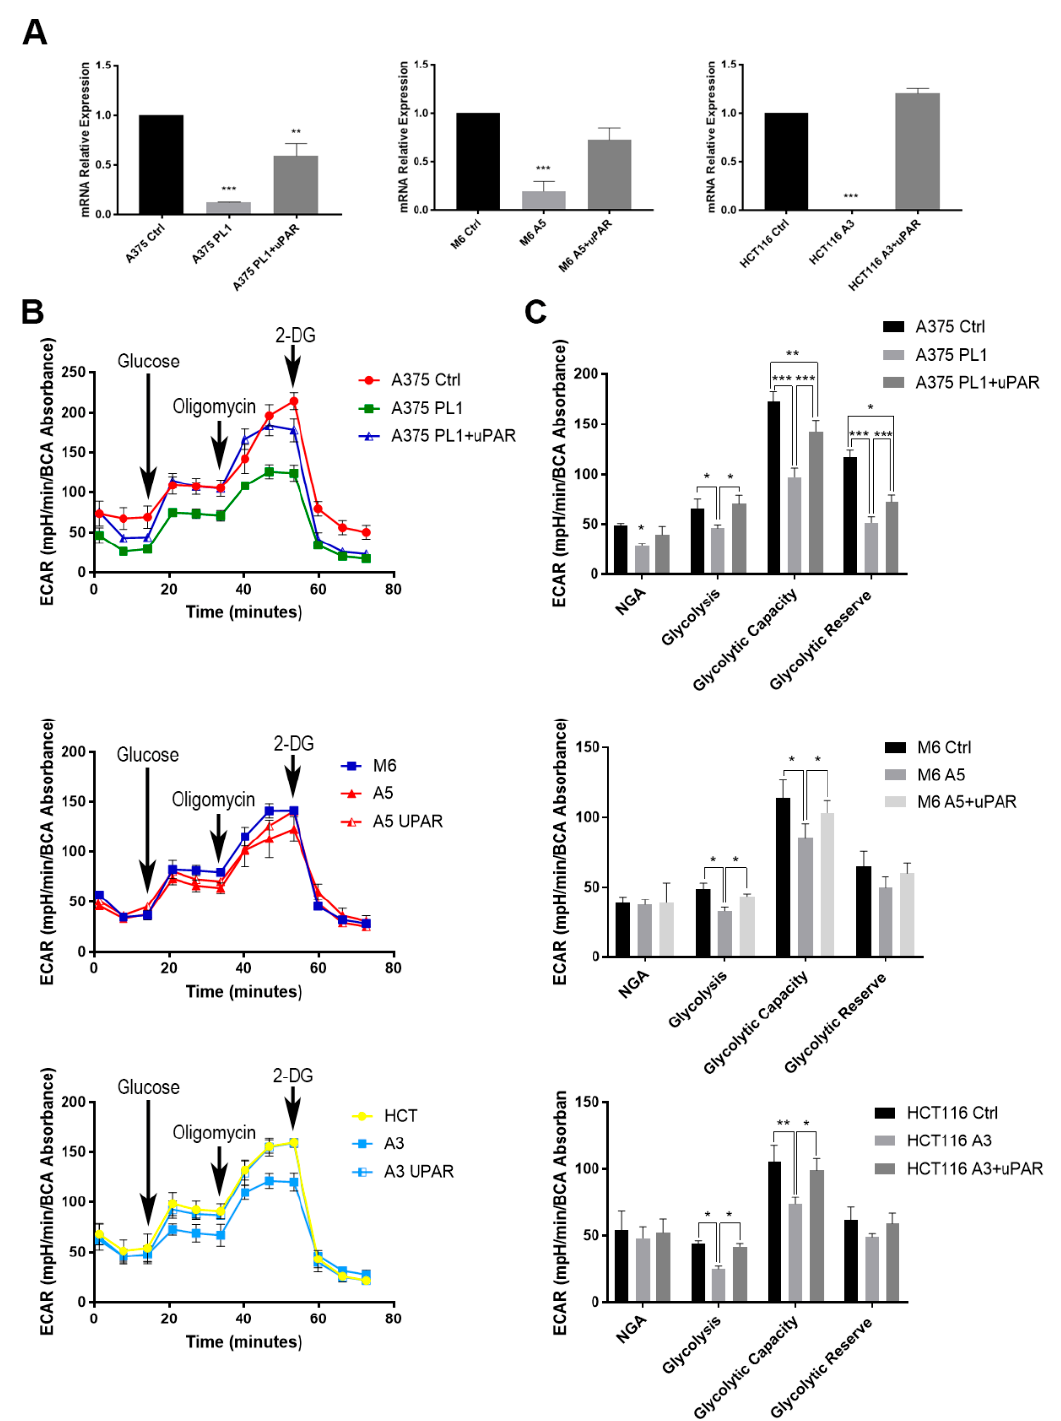
Figure 3. ( A ) Total RNA isolated was subjected to quantitative PCR (qPCR) analysis of